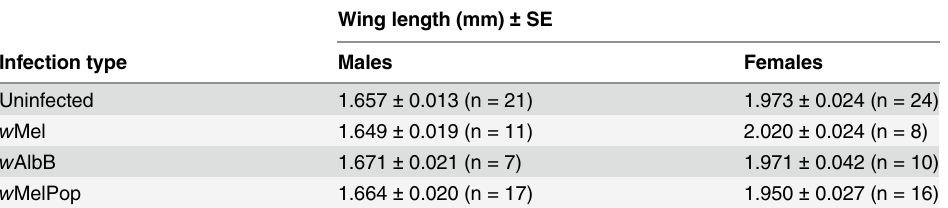
Table 3. Wing lengths of Ae . aegypti adults emerging from groups of larvae held under starvation conditions.